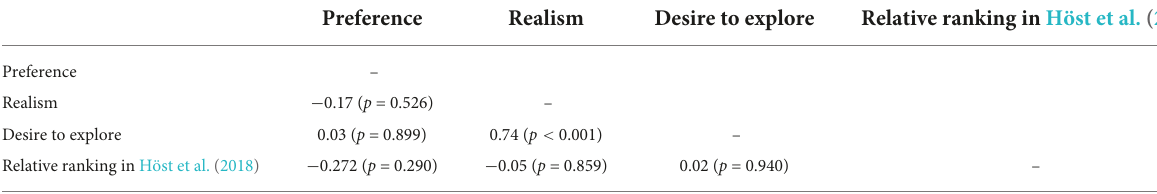
TABLE 2 Spearman’s rho correlation coefficients between image scores for preference, realism, desire to explore and relative ranking in previous data (Höst et al., 2018).